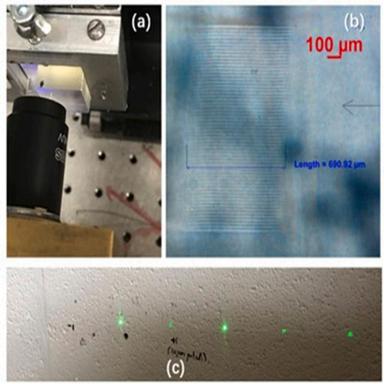
(a) Internal engraving using a digital aperture of approximately 0.4 nearultraviolet combined objective focus; (b) Side-view photomicrograph of a Bragg-like grating approximately 690 μm thick; (c) Primary diffraction test of the impaling angle incidence of a laser with a wavelength of 532 nm.